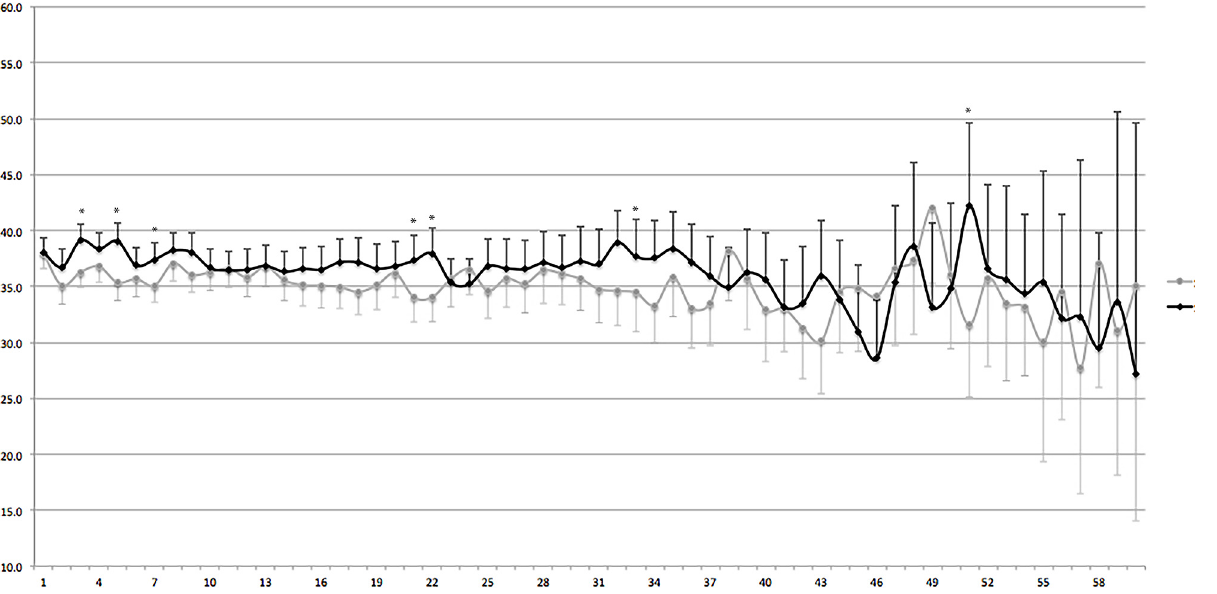
Fig 4. Blood pressure behavior along the study period. Legend: Markers represent mean systolic and diastolic blood pressure whilst error bars represents confidence interval 95%. The bottom box indicates the absolute number of patients included in the analysis per group.